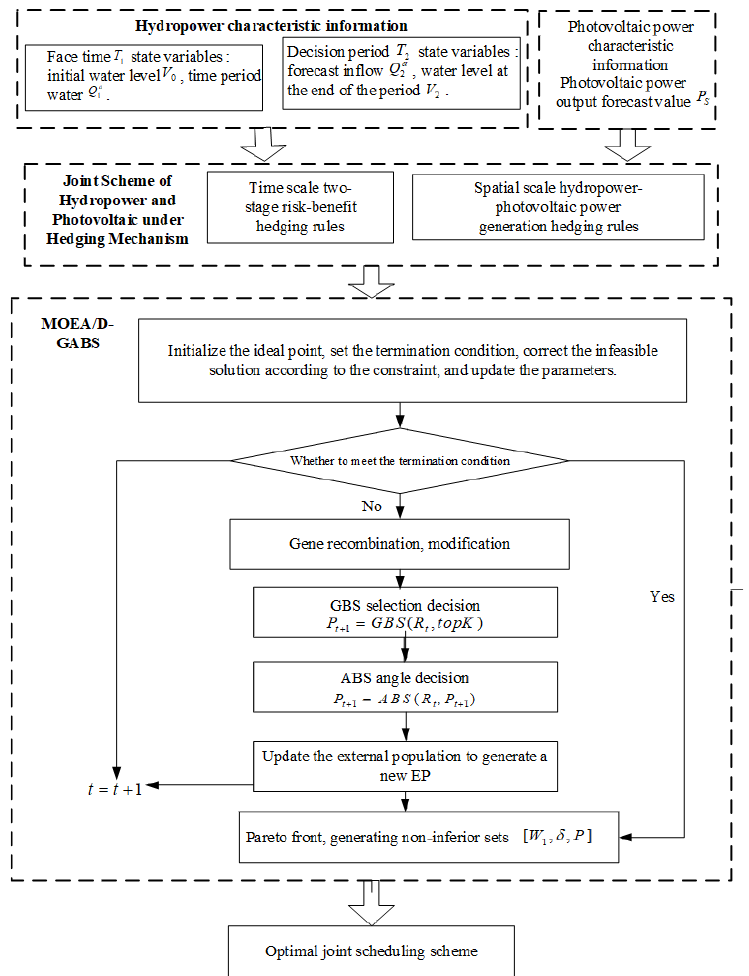
Figure 10. Hydropower photovoltaic joint dispatch in a flow chart based on the MOEA/D-GABS Figure 10. algorithm.